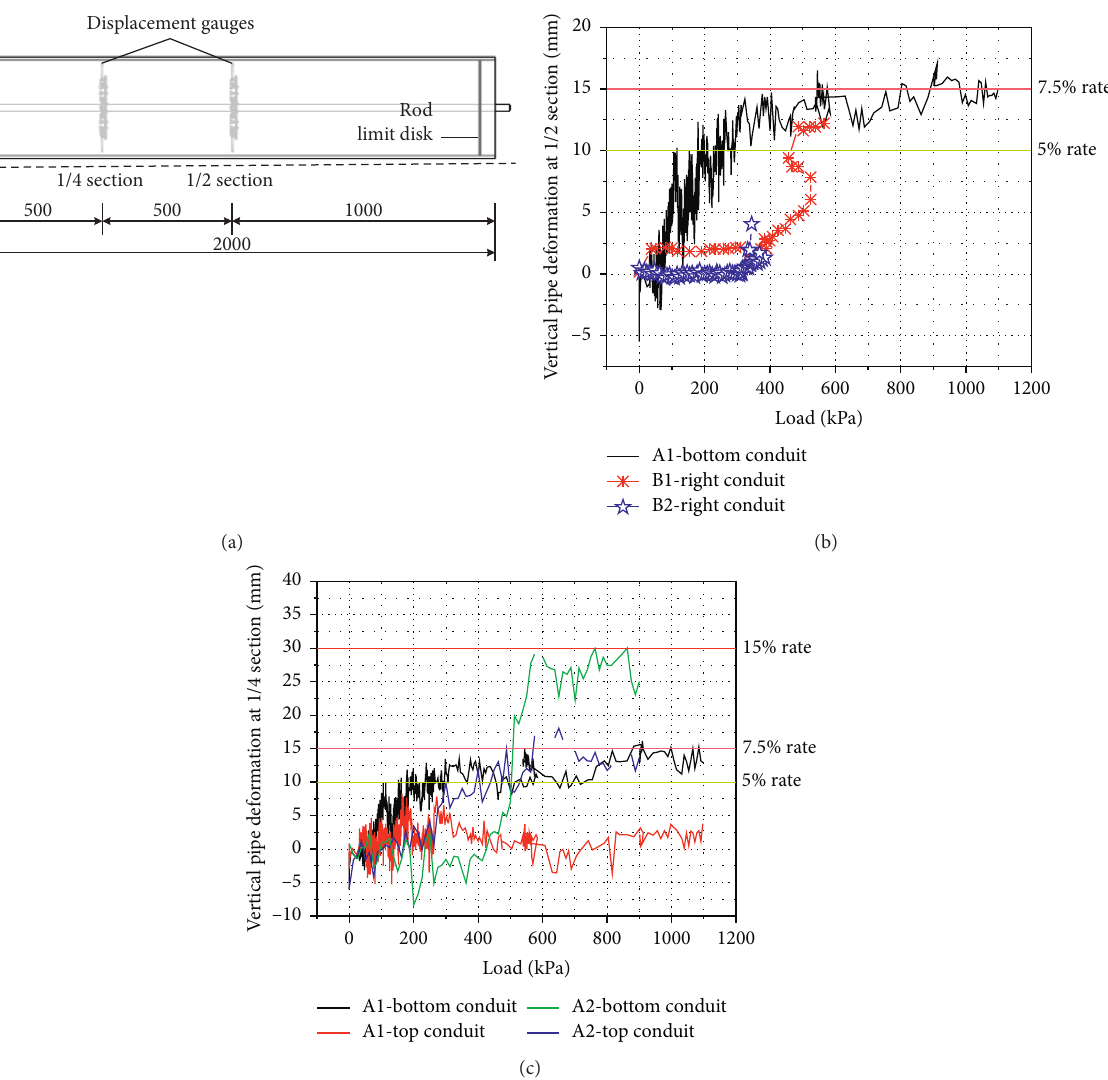
Figure 15: Vertical deformation of HDPE conduits. (a) Measuring points of HDPE conduits: (b) 1/2 section and (c) 1/4 section.